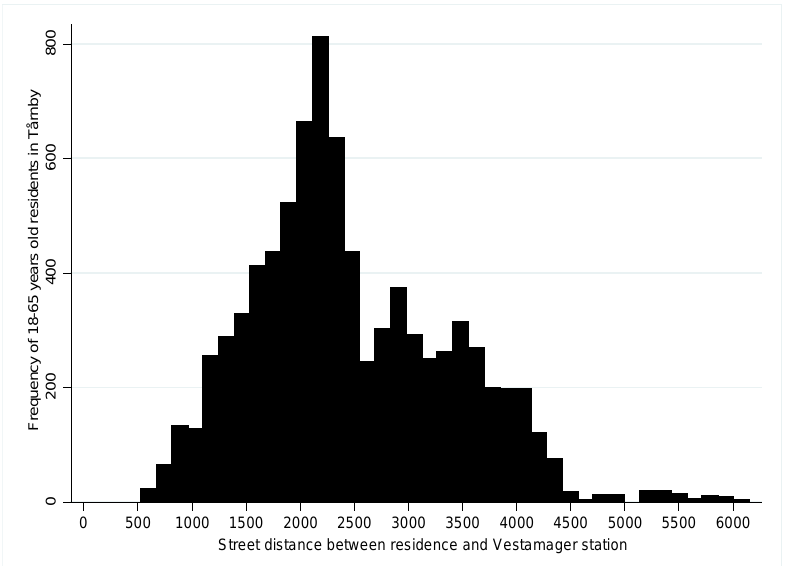
Figure 2. Distribution of distances between residence and the under-construction Vestamager station in